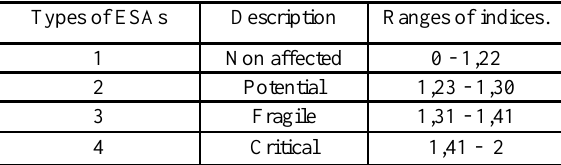
Table8. Types of ESAs and corresponding ranges of indices Types of ESAs Ranges of indices.